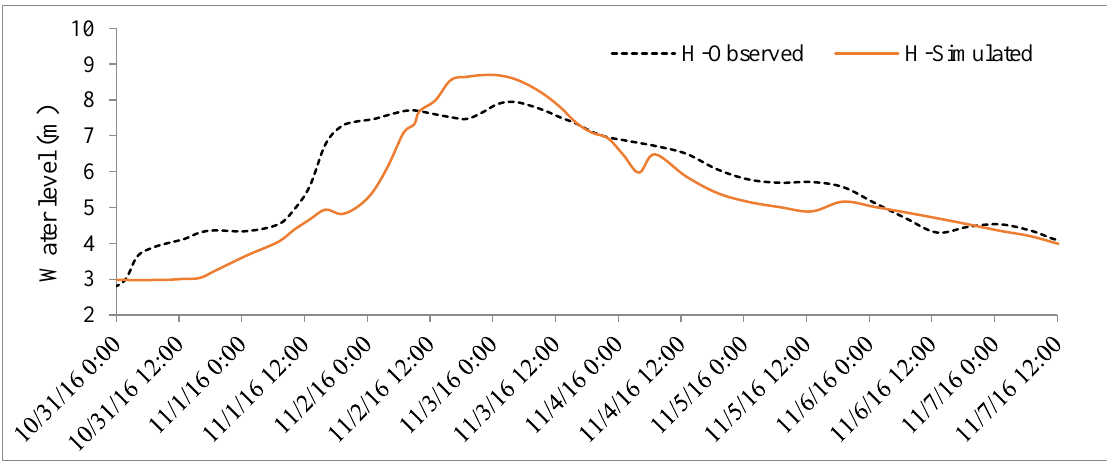
Figure 11. The calibration water level at the Cau Lau hydrological station at the VGTB river basin during October 14–19, 2015 flood event.